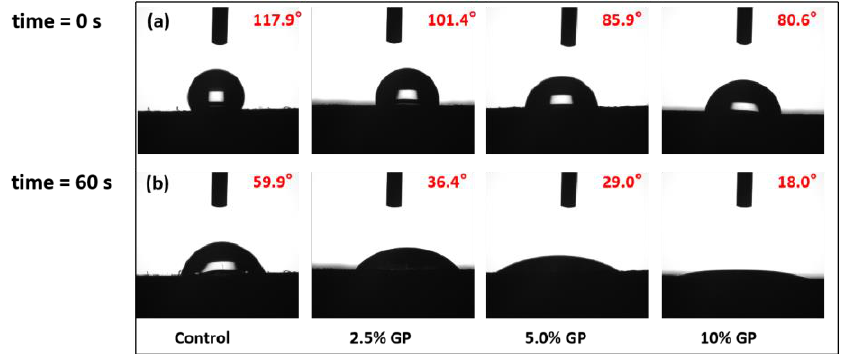
Figure 7. Water droplet morphology and contact angle on control wood and GP-modified wood surface with time; ( a ) time = 0 s; ( b ) time = 60 s.